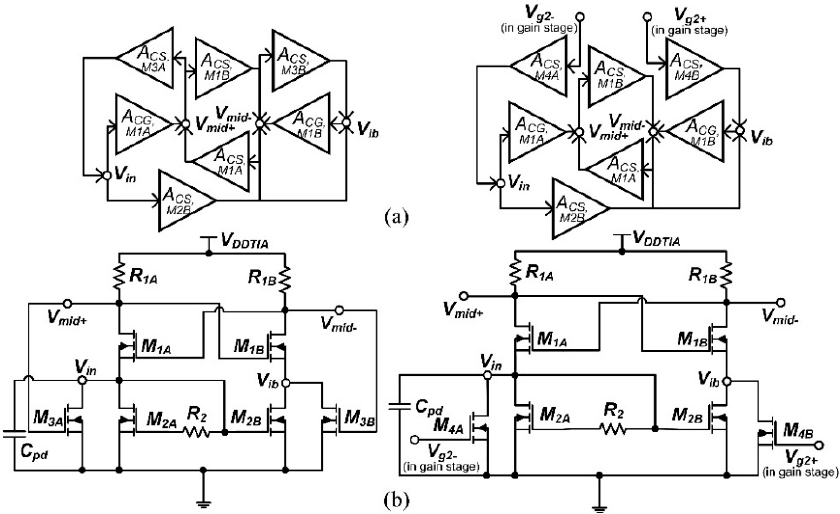
Figure 4. ( a ) Simplified and ( b ) transistor-level schematic of the proposed DVGTIA input stage design 1 and ( b ) design 2.